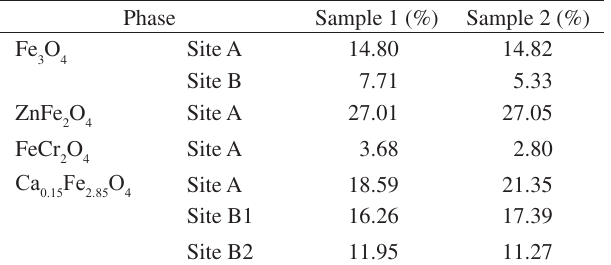
Table 7. Q�a�tificatio� o� the mai�ly oxides phases i� the st�died EAFD samples.